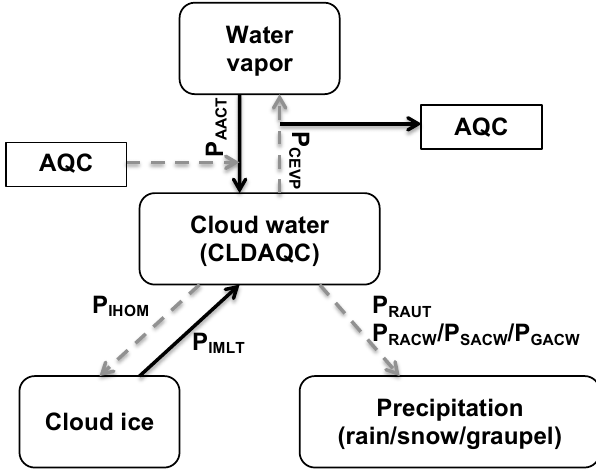
Figure 1. Cloud physics processes that are involved with cloud par- ticles in the SOWC model with a 6-D aerosol variable (AQC) and a 6-D cloud variable (CLDAQC) included. The black solid arrow and the gray dashed arrow indicate the source and the sink processes of cloud water and 6-D CLDAQC, as well as 6-D AQC,